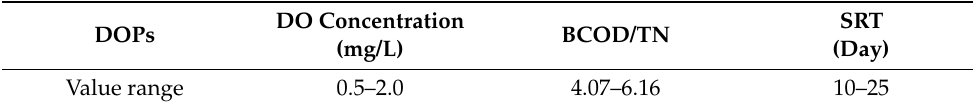
Table 4. Value range of DOPs in optimization experiments.